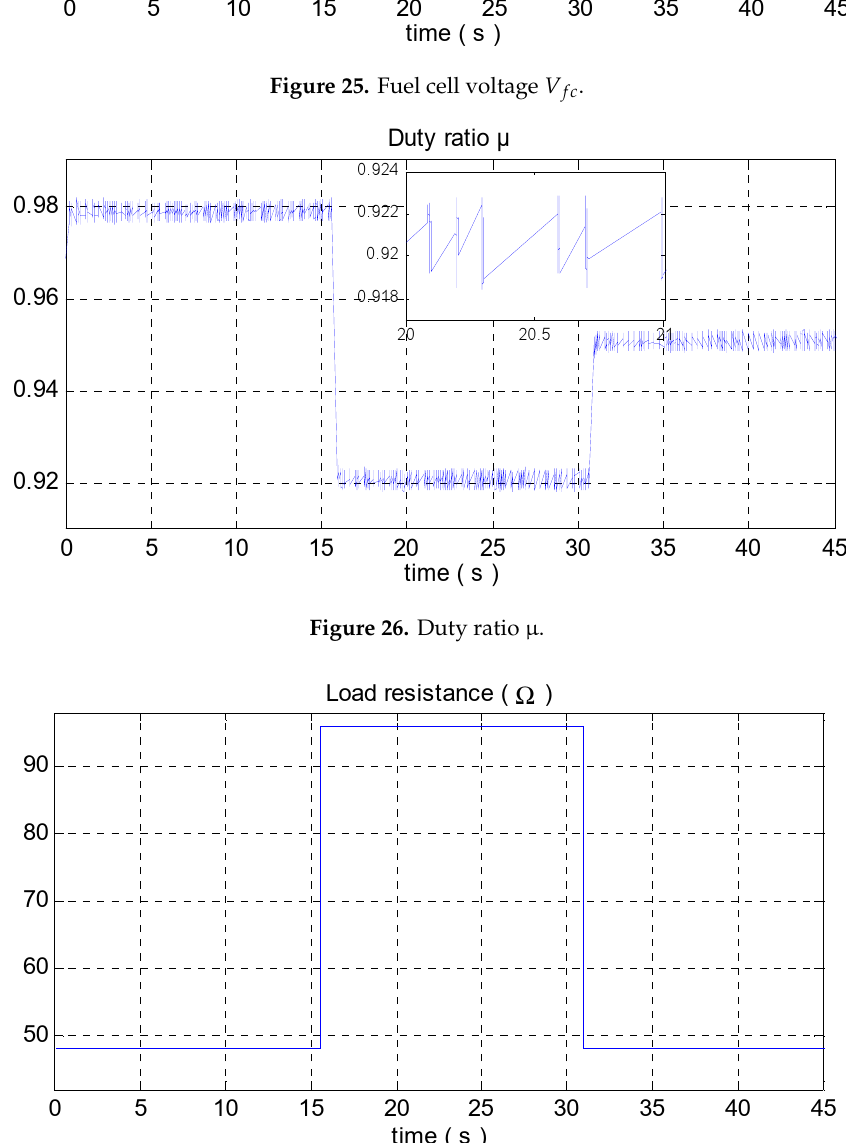
Figure 27. Programmed profile of the load resistance.